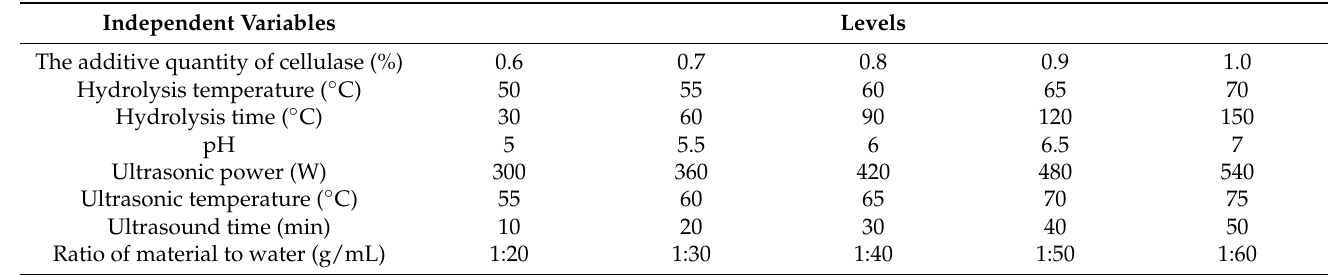
Table 5. Ultrasound-assisted cellulase extraction of Moringa oleifera polysaccharides one-way experi- mental